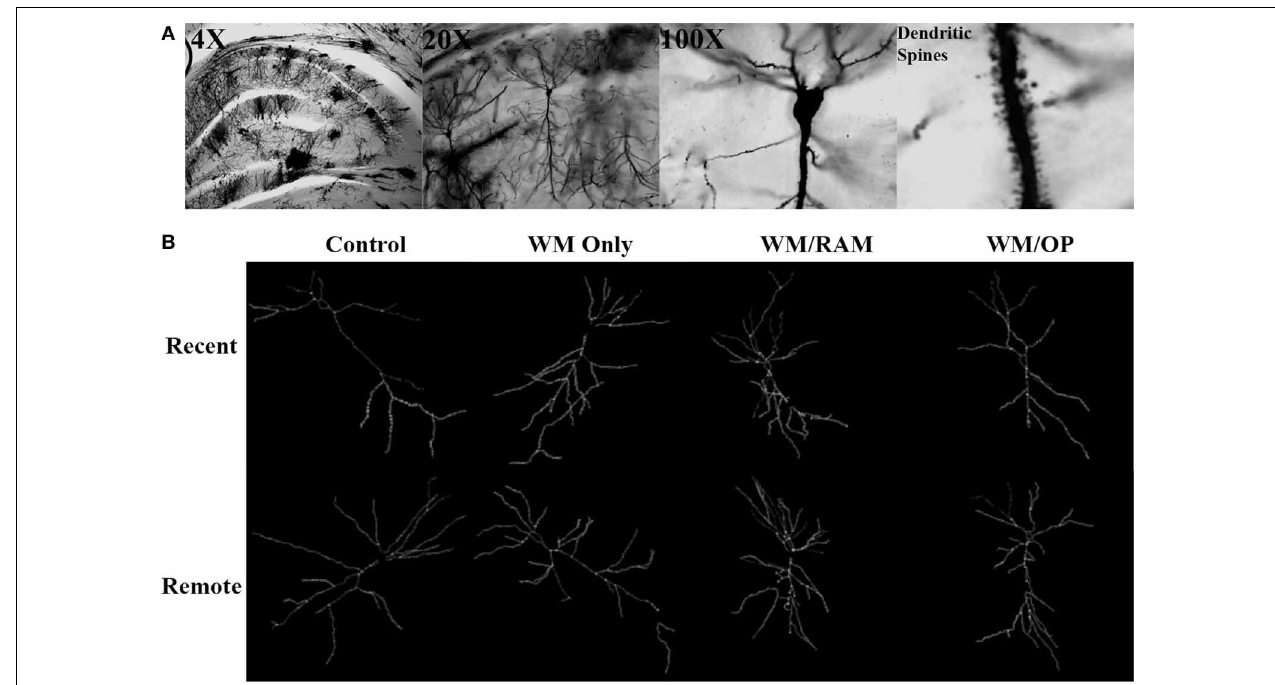
FIGURE 8 | (A) Images of 4X, 20X, and 100X magnified Golgi impregnated neurons in the CA1. A zoomed-in image of an apical dendrite with dendritic spines is shown in the last panel. (B) Representative graphics of Golgi impregnated neurons in the CA1, traced using Neurolucida